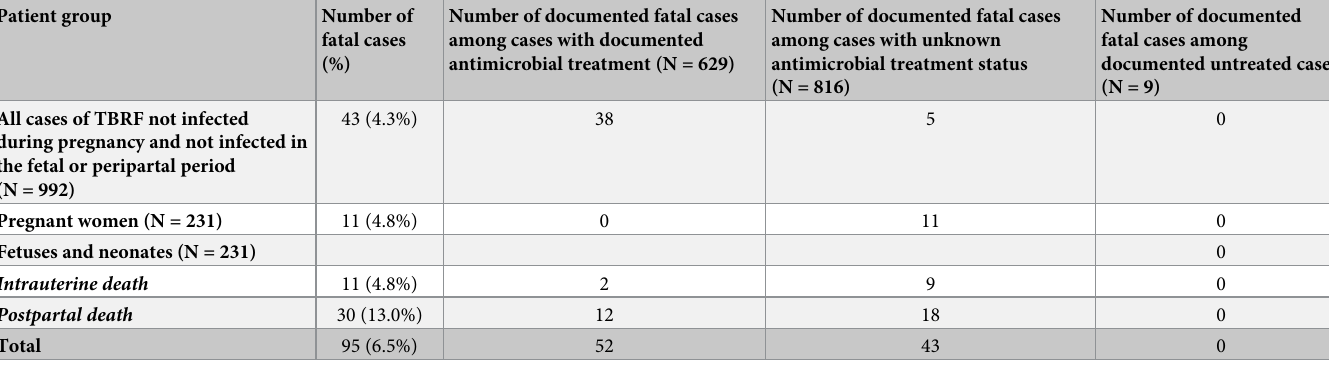
Table 8. Case fatality analysis of TBRF (n = 17